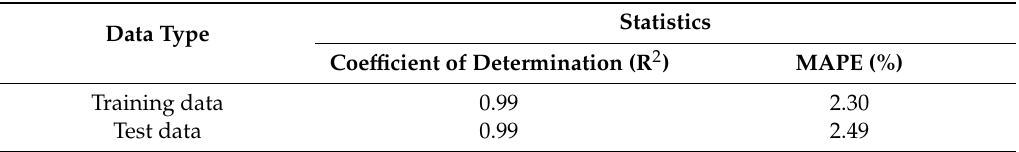
Figure 8. Results of accuracy analysis of DNN models for predicting crusher utilization with different numbers of hidden layers and hidden layer nodes: coefficient of determination for ( a ) training data and ( b ) test data, and MAPE for ( c ) training data and ( d ) test data. Table 7. Results of evaluating coefficient of determination and MAPE of optimal DNN model, with four hidden layers and 40 hidden layer nodes, for predicting crusher utilization.